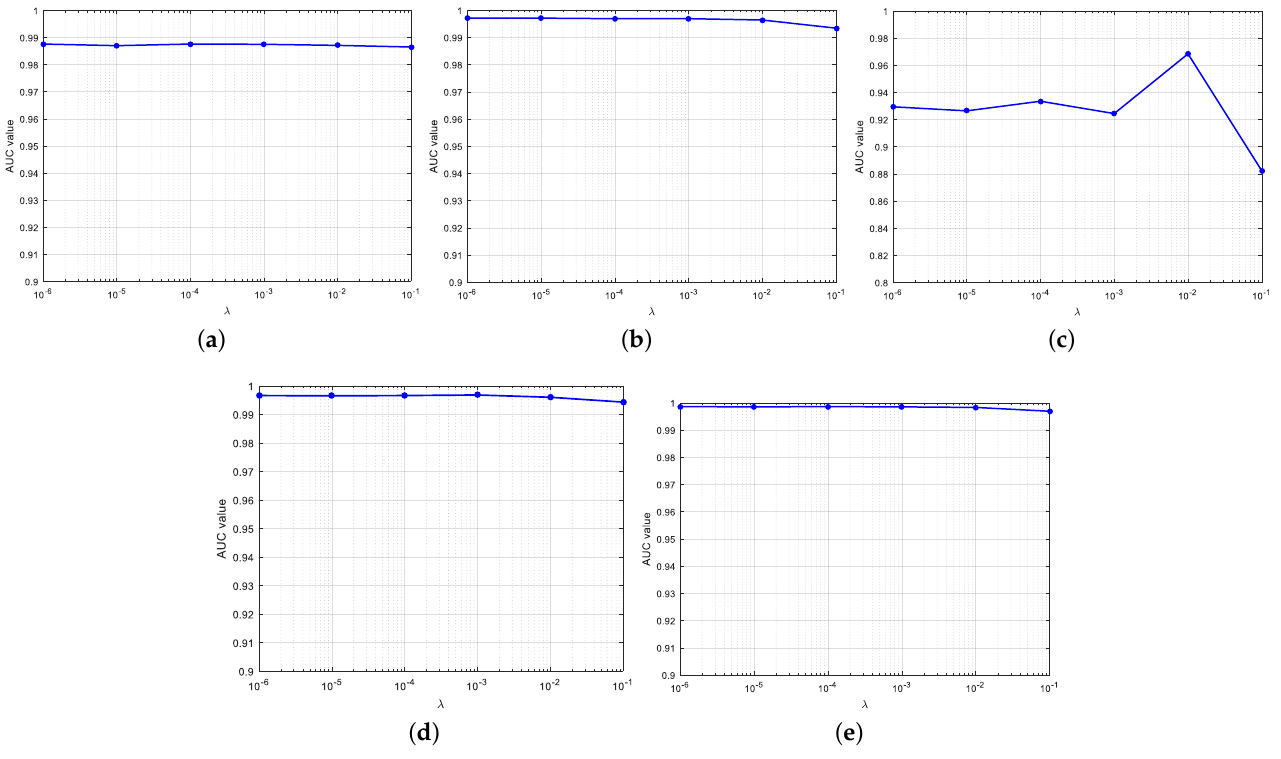
Figure 5. AUC values with respect to the positive tradeoff parameter λ . ( a ) San Diego − I; ( b ) San Diego − II; ( c ) Los Angeles − I; ( d ) Los Angeles − II; ( e ) Texas